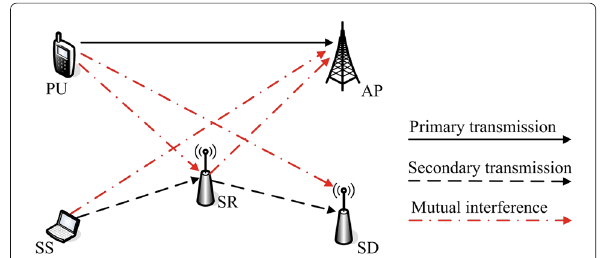
Fig. 1 Cognitive DF relaying with SIC decoding at SR and